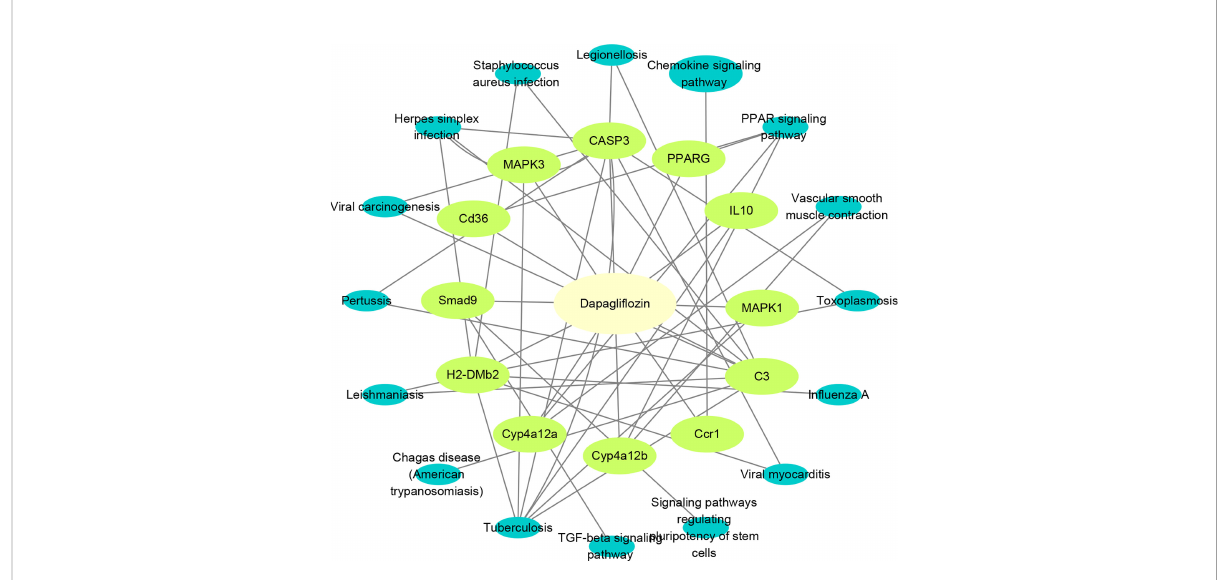
FIGURE 7 Construction of component-target-pathway network. Light yellow represents dapagli fl ozin, light green represents potential targets and dark blue represents gene-related signaling pathways.